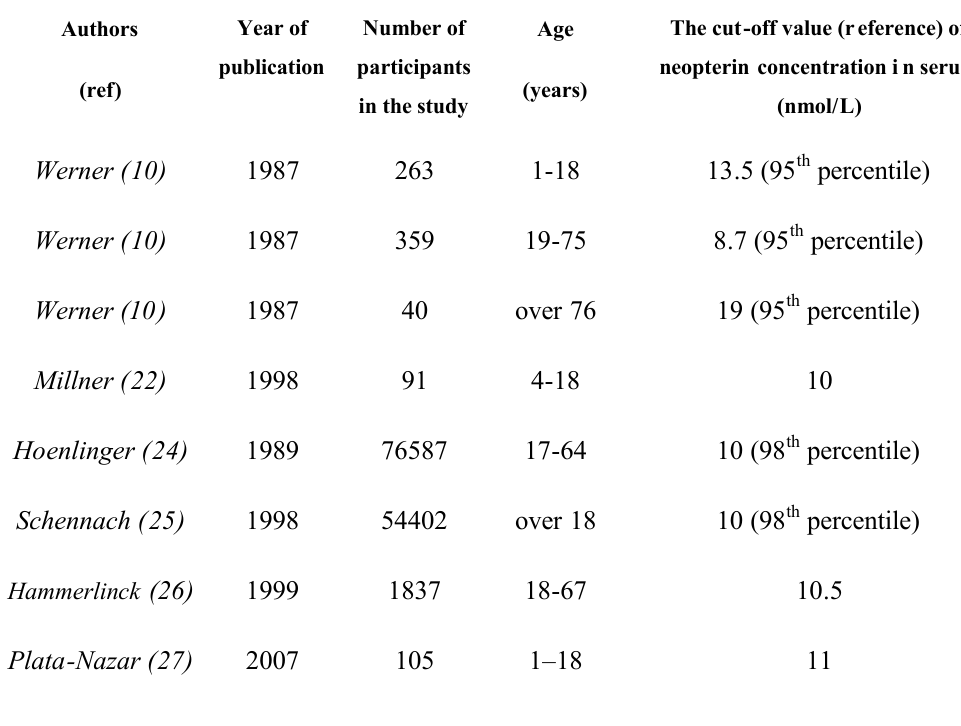
Table 1. Reference values of concentration of neopterin in serum published in different